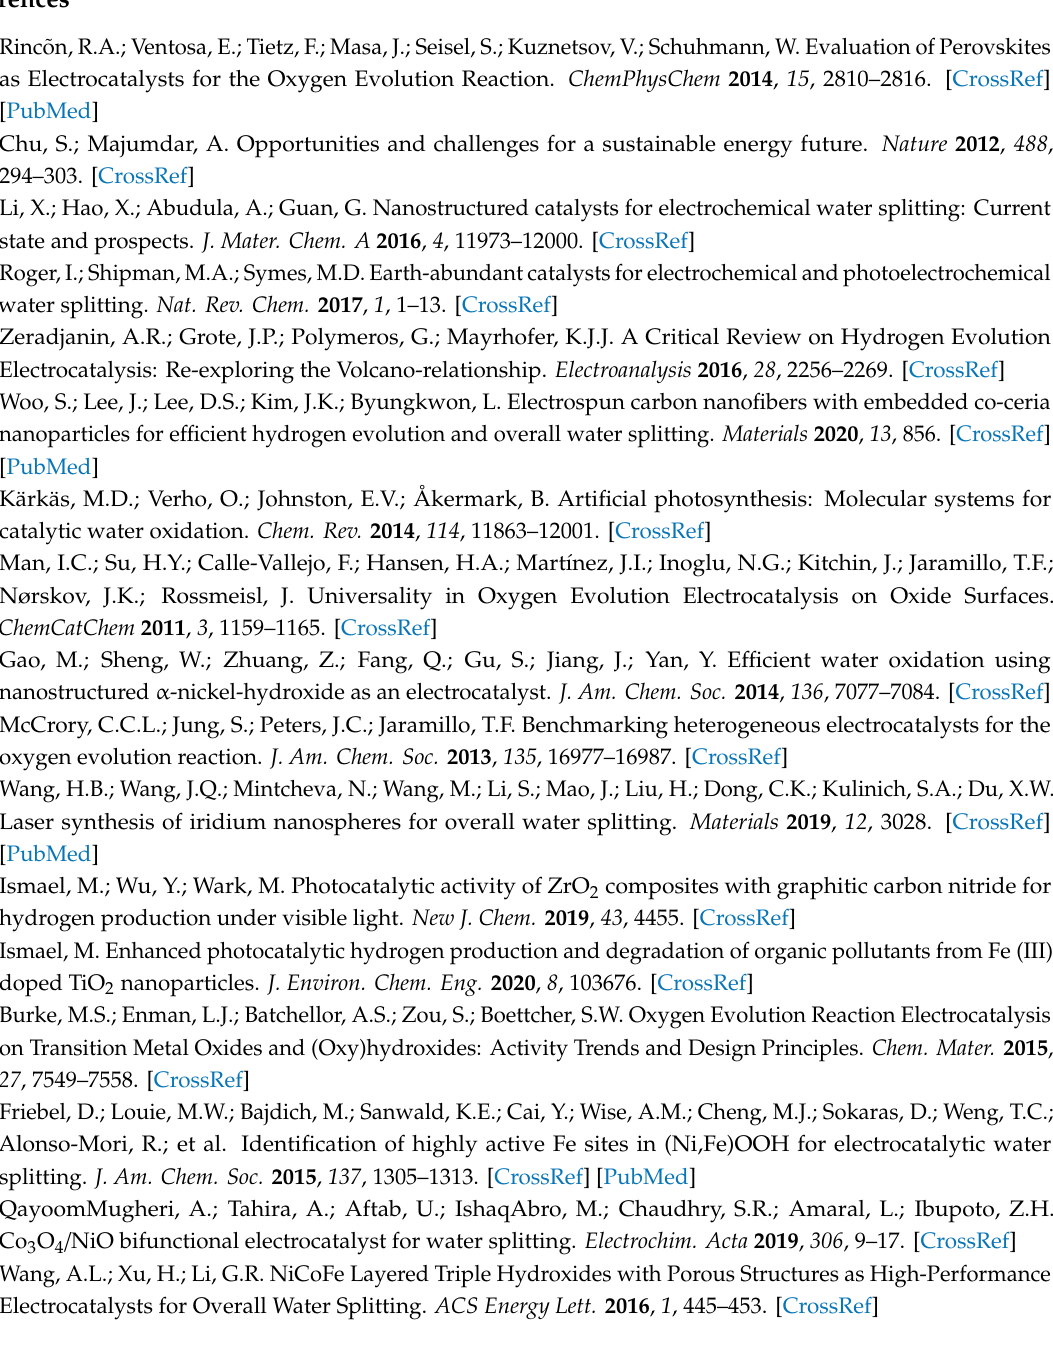
between FC and FCCD25, Table S1: Electrochemical parameters for di ff erent electrocatalysts, Table S2: Performance comparison for di ff erent electrocatalysts compared to